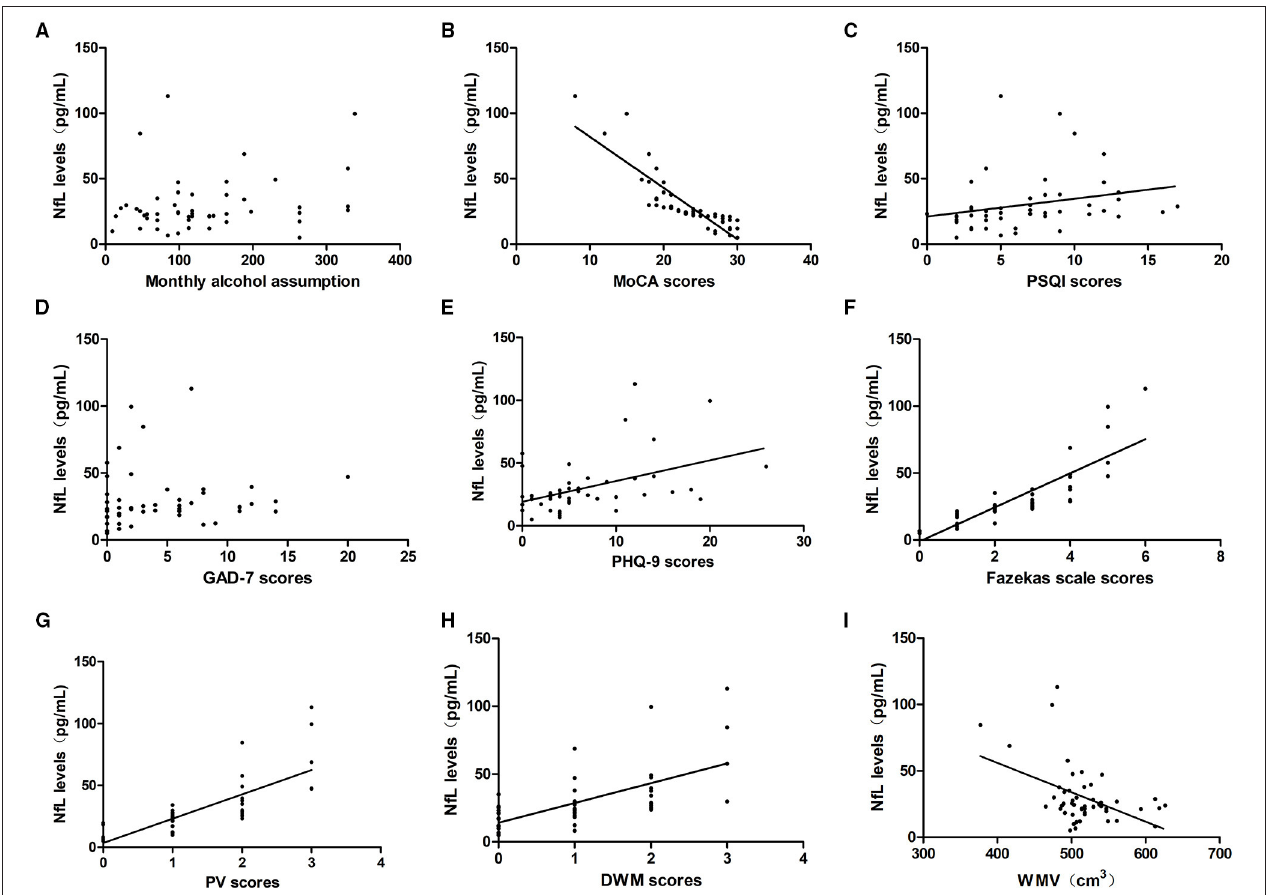
FIGURE 4 | Relationship between serum NfL levels and alcohol assumption, neuropsychological function, the severity of WMLs, and WMV in the alcohol dependence group. Correlation of serum NfL levels with (A) monthly alcohol consumption, (B) MoCA scores, (C) PSQI scores, (D) GAD-7 scores, (E) PHQ-9 scores, (F) Fazekas scale scores, (G) PV scores and (H) DWM scores, (I) GMV. NfL levels were irrelevant to monthly alcohol assumption and GAD-7 scores ( P > 0.05). NfL levels were negatively correlated with MoCA scores and WMV, and positively correlated with PSQI scores, PHQ-9 scores, Fazekas scale scores, PV scores, and DWM scores ( P <